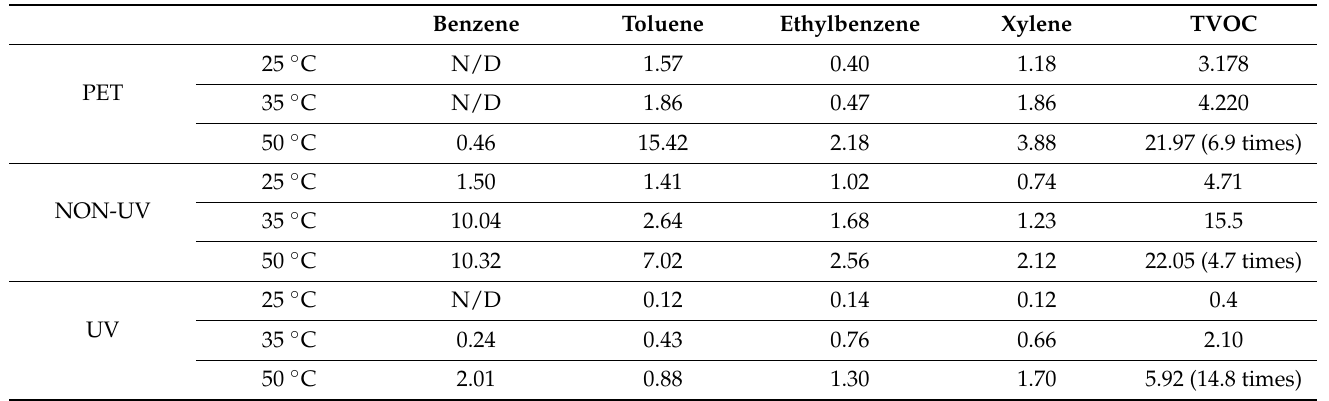
Table 5. Laboratory measurement results of VOCs radiation from flooring (unit: µ g/m 2